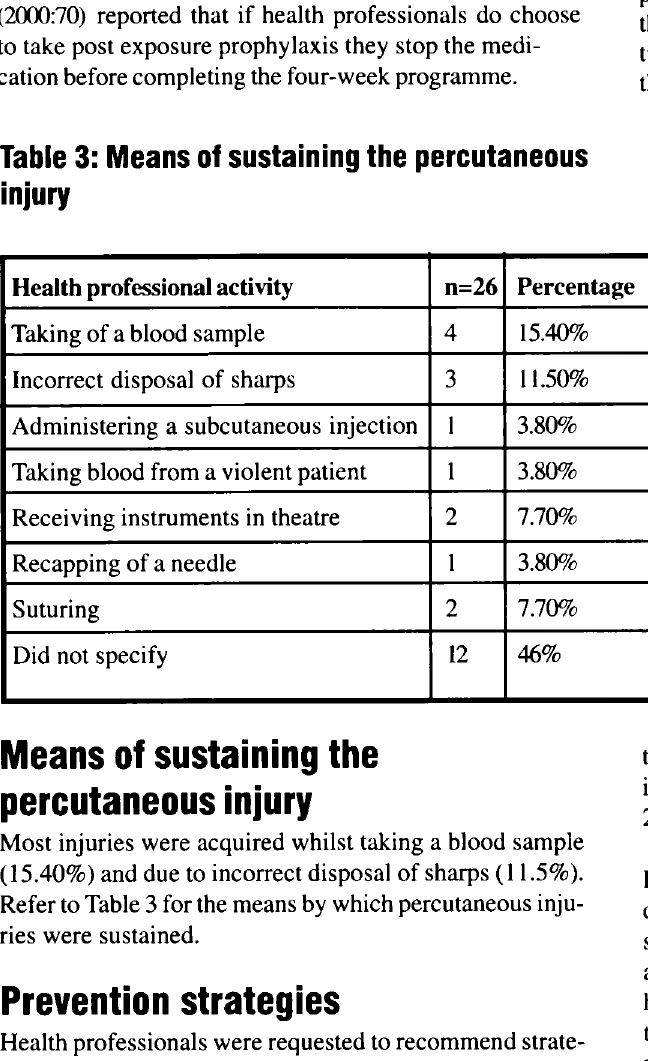
Health professional activity n=26 Percentage Taking of a blood sample Incorrect disposal of sharps Administering a subcutaneous